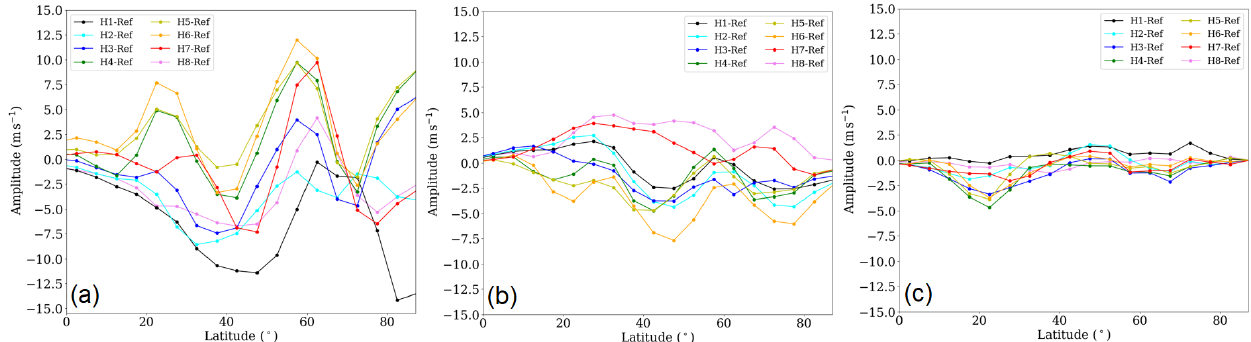
Figure 6. Zonal-mean zonal wind SPW 1 (a) , SPW 2 (b) and SPW 3 (c) amplitudes at 35km altitude. Shown are differences between the H1–H8 and the Ref simulation.